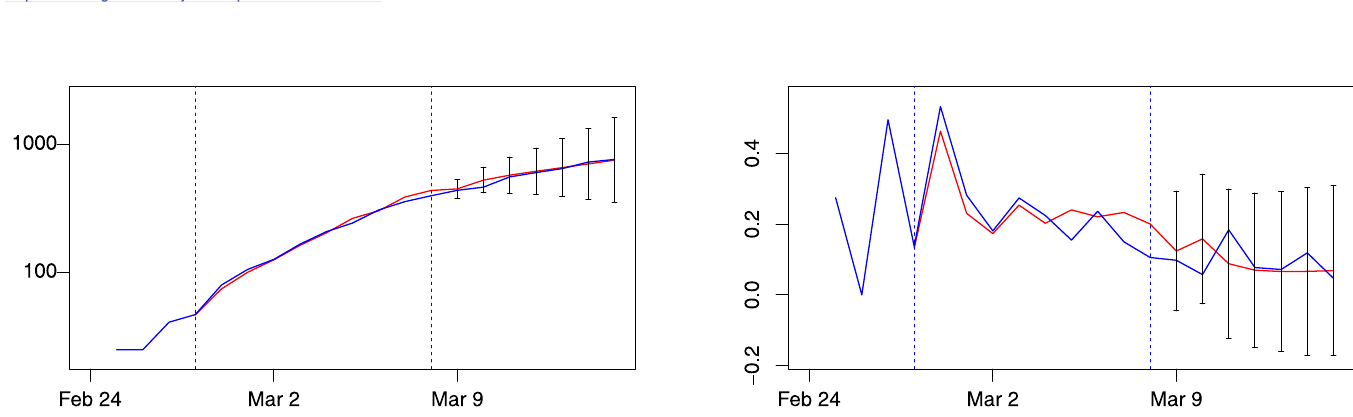
Bold entries correspond to the model with smallest MAE or MAPE for the given forecast week.